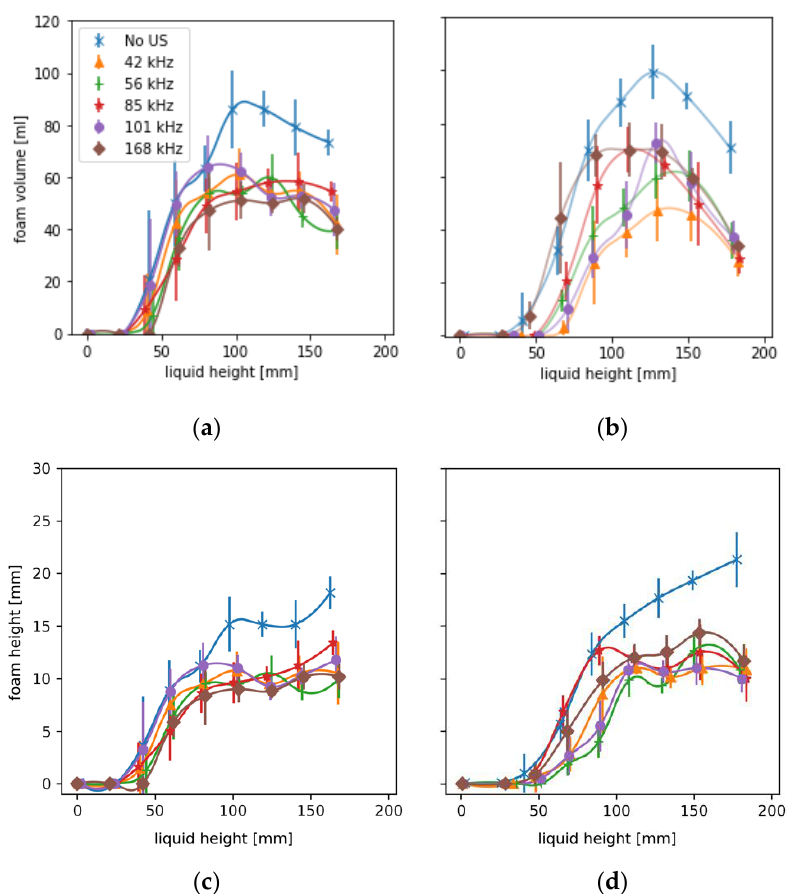
Figure 5. Effect of frequency depended ultrasound insonication with 2 s delay on the evolution of foam volume ( a , b ) and foam height ( c , d ) for apple juice ( a , c ) and currant nectar ( b , d ), each at 70 °C, n = 6.